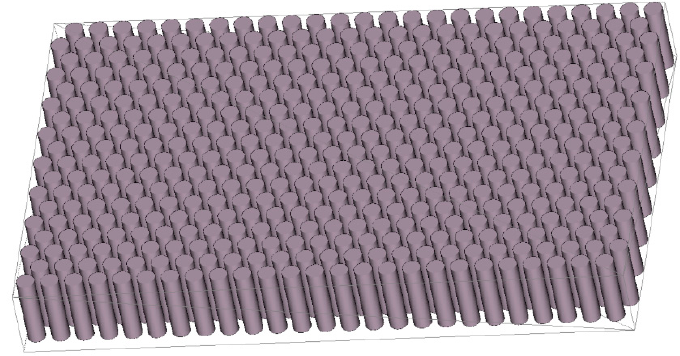
Figure 16. Arrangement of the CGx on BP_1_2-1 and 1_3-1.